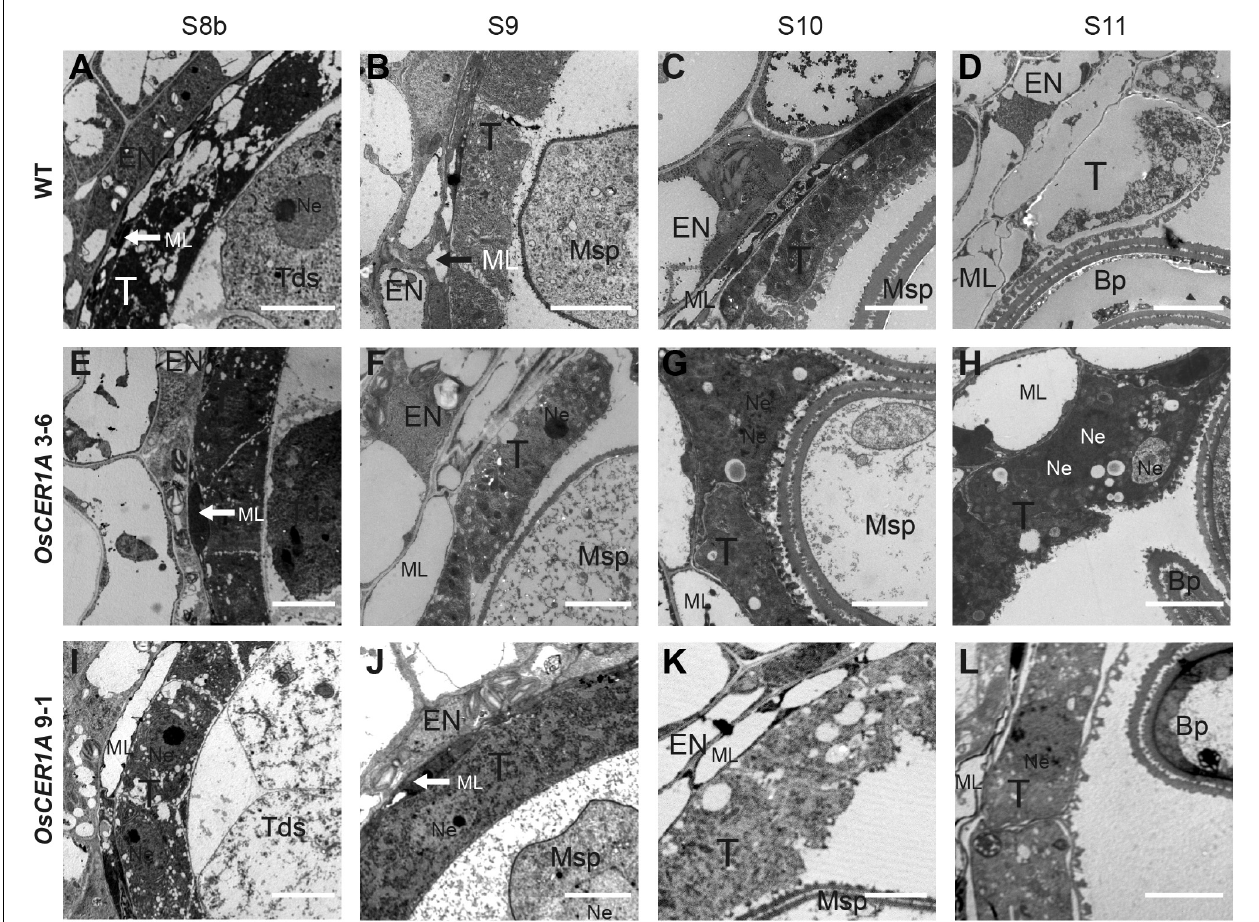
FIGURE 5 | Comparison of transmission electron microscopy (TEM) of anthers from the WT plants and OsCER1A lines. (A–D ) TEM analysis of the WT anthers at stage 8b (S8b) (A) , stage 9 (S9) (B) , stage 10 (S10) (C) , and stage 11 (S11) (D) . (E–H) TEM analysis of the OsCER1A 3-6 anthers at S8b (E) , S9 (F) , S10 (G) , and S11 (H) . (I–L) TEM analysis of the OsCER1A 9-1 anthers at S8b (I) , S9 (J) , S10 (K) , and S11 (L) . Bp, bicellular pollen; En, endothecium; ML, middle layer; Msp, microspore; Ne, nucleus; T, tapetum; Tds, tetrads. Bars = 10 µ